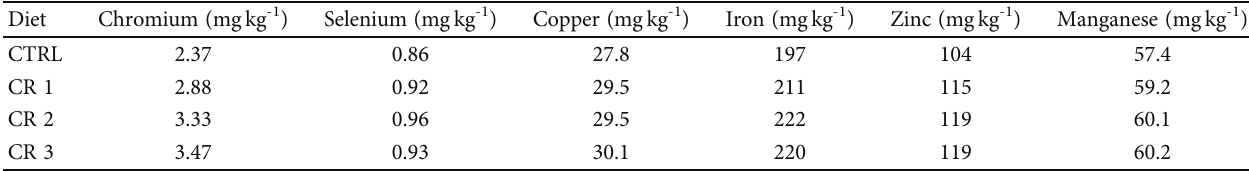
Table 4: Trace mineral content of the diets.